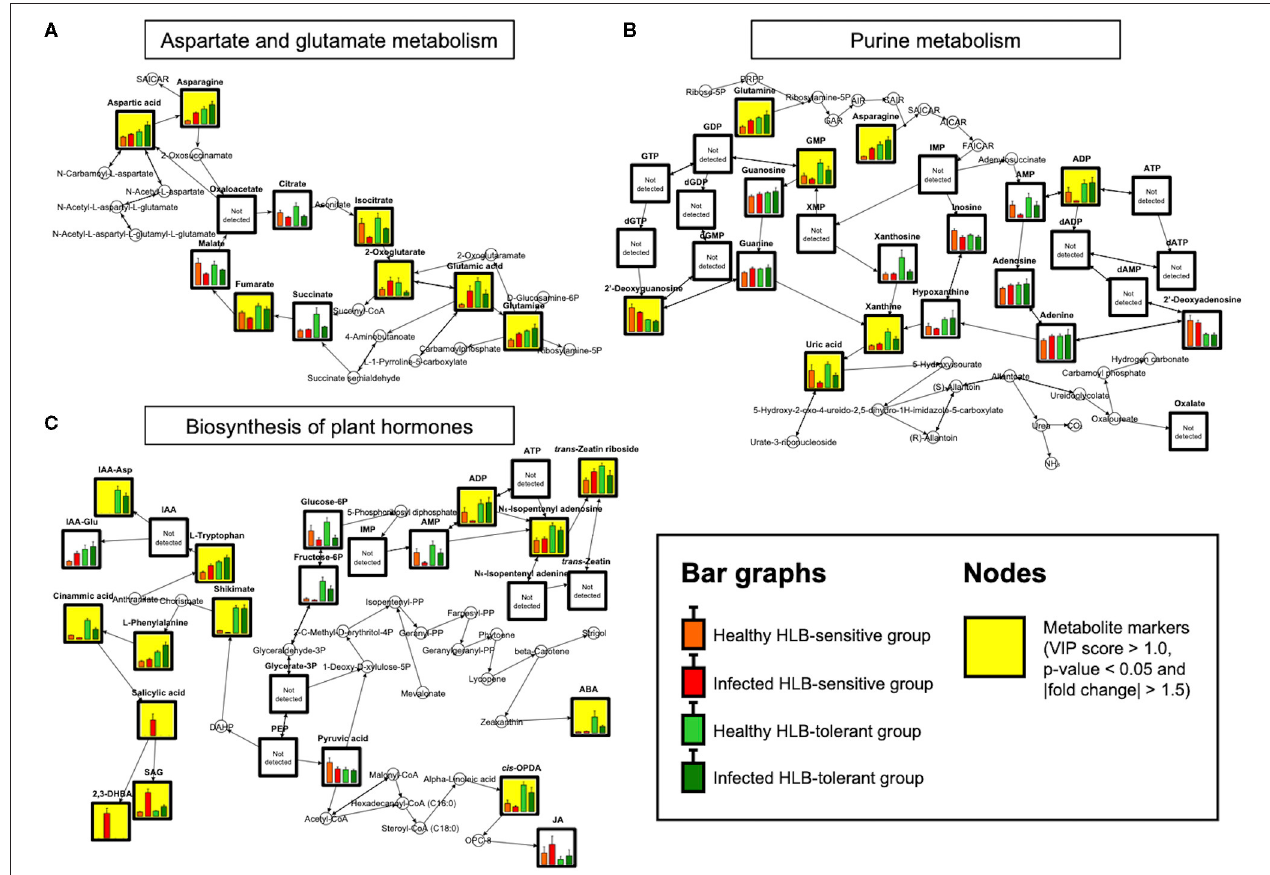
FIGURE 2 | Metabolite mapping on (A) AGM (B) PM, and (C) BPH pathways ( n = 9). Bar graphs show metabolite levels with SE in healthy HLB-sensitive group (orange), infected HLB-sensitive group (red), healthy HLB-tolerant group (light green), and infected HLB-tolerant group (green) based on the integrated results. Yellow background indicates marker compounds (VIP score > 1.0, p -value < 0.05, and |fold change| > 1.5) in the